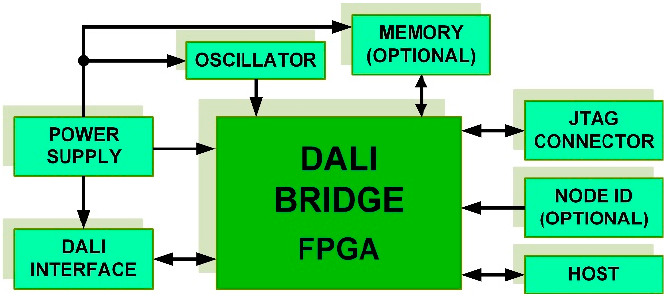
Figure 16. Basic Components to implement the DALI Bridge in an FPGA in a Wireless Sensor Node.